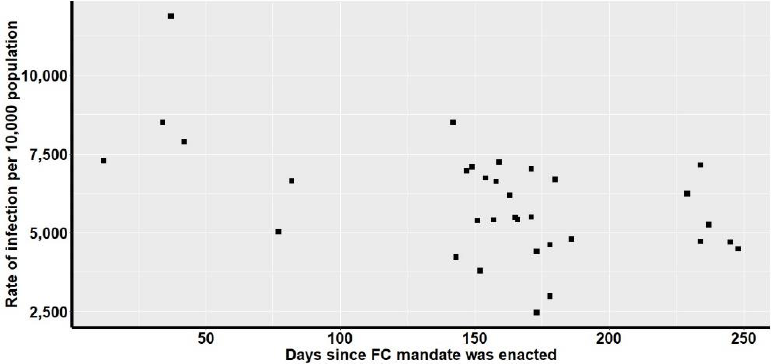
Figure 2. Scatter plot of correlation between the number of days since the FC mandate was passed and the rate of COVID-19 infection cases by the end of Fall 2020 (21